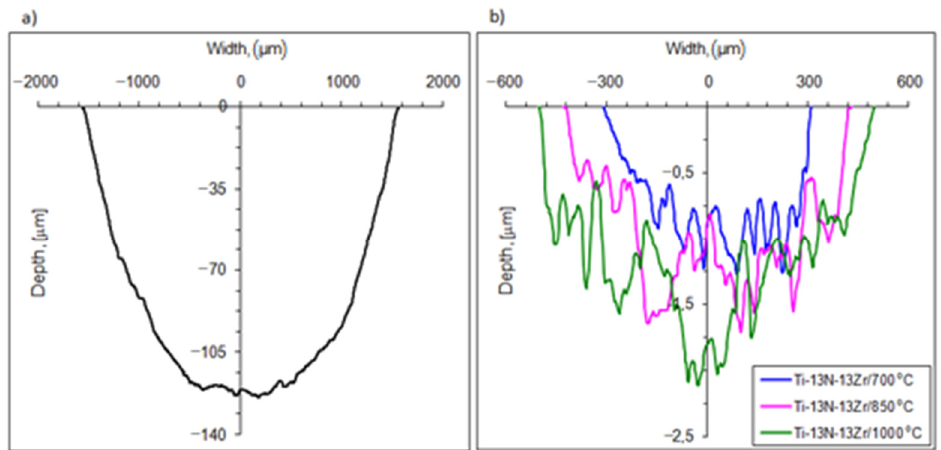
Figure 7. Cross-section profile of wear track of as-received Ti–13Nb–13Zr alloy ( a ) and hardened Ti–13Nb–13Zr alloy ( b ) after dry friction.